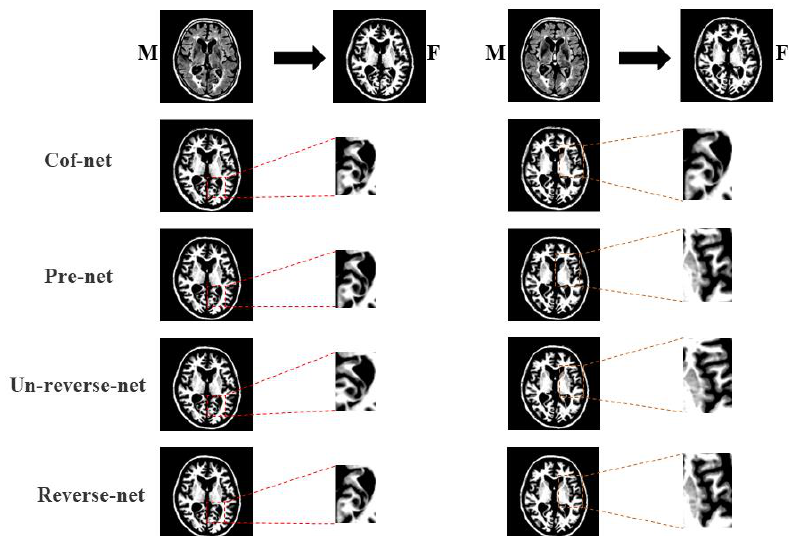
Figure 7. Results of ablation experiments on MRbrain.